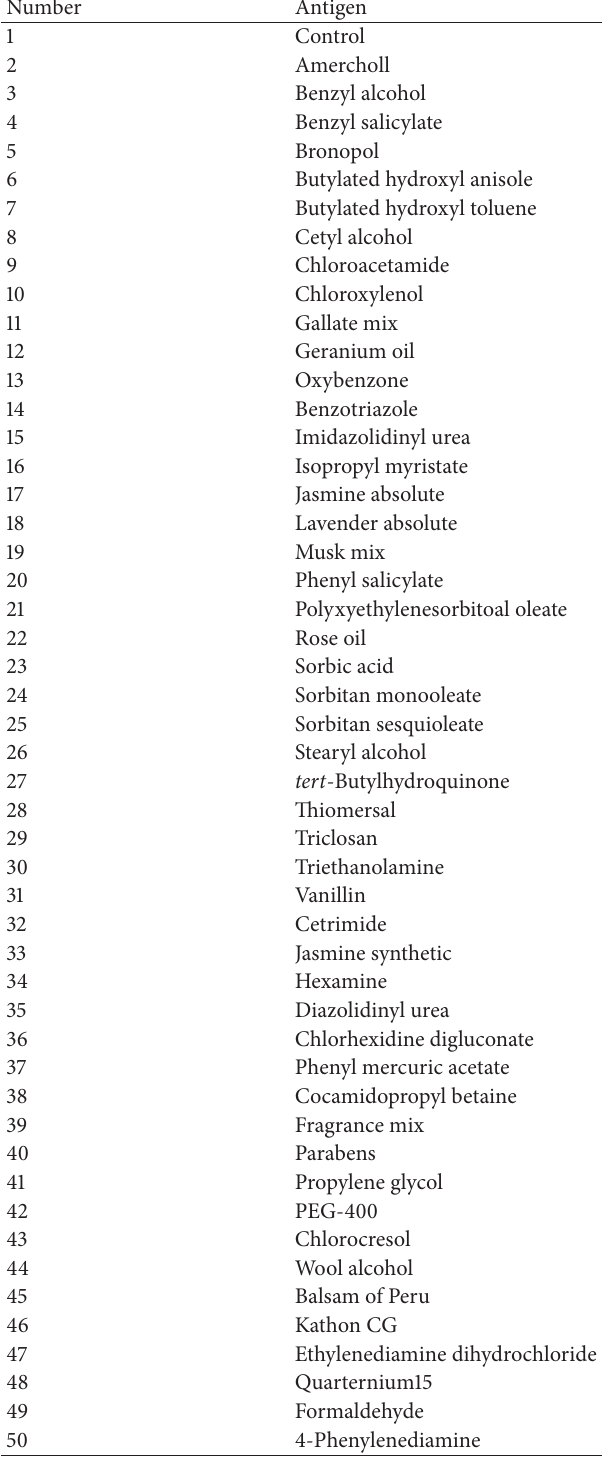
Table 1: List of antigens used (1–38 Cosmetic Series, 39–50 Standard